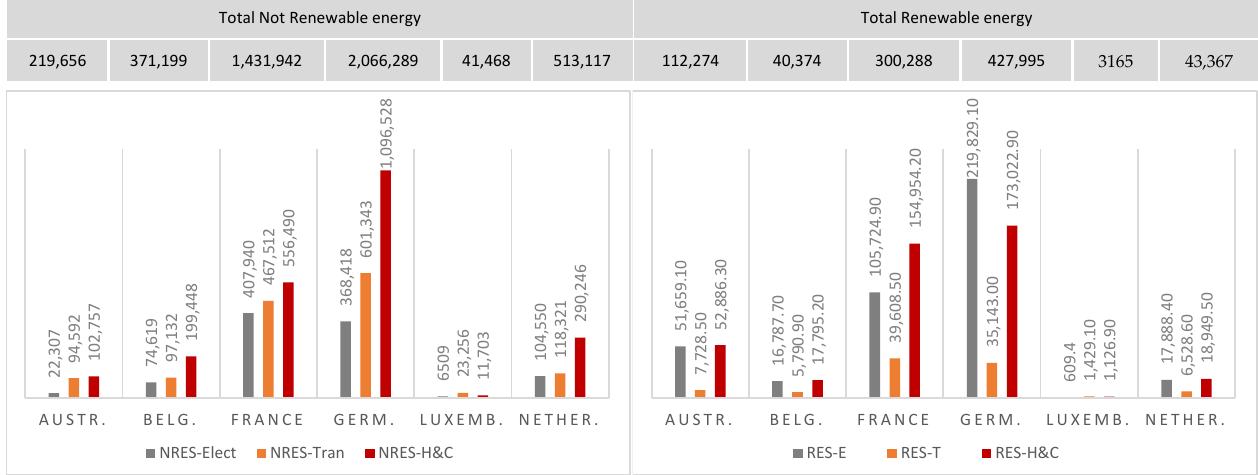
Figure 4. Energy consumption (GWh) in 2018.